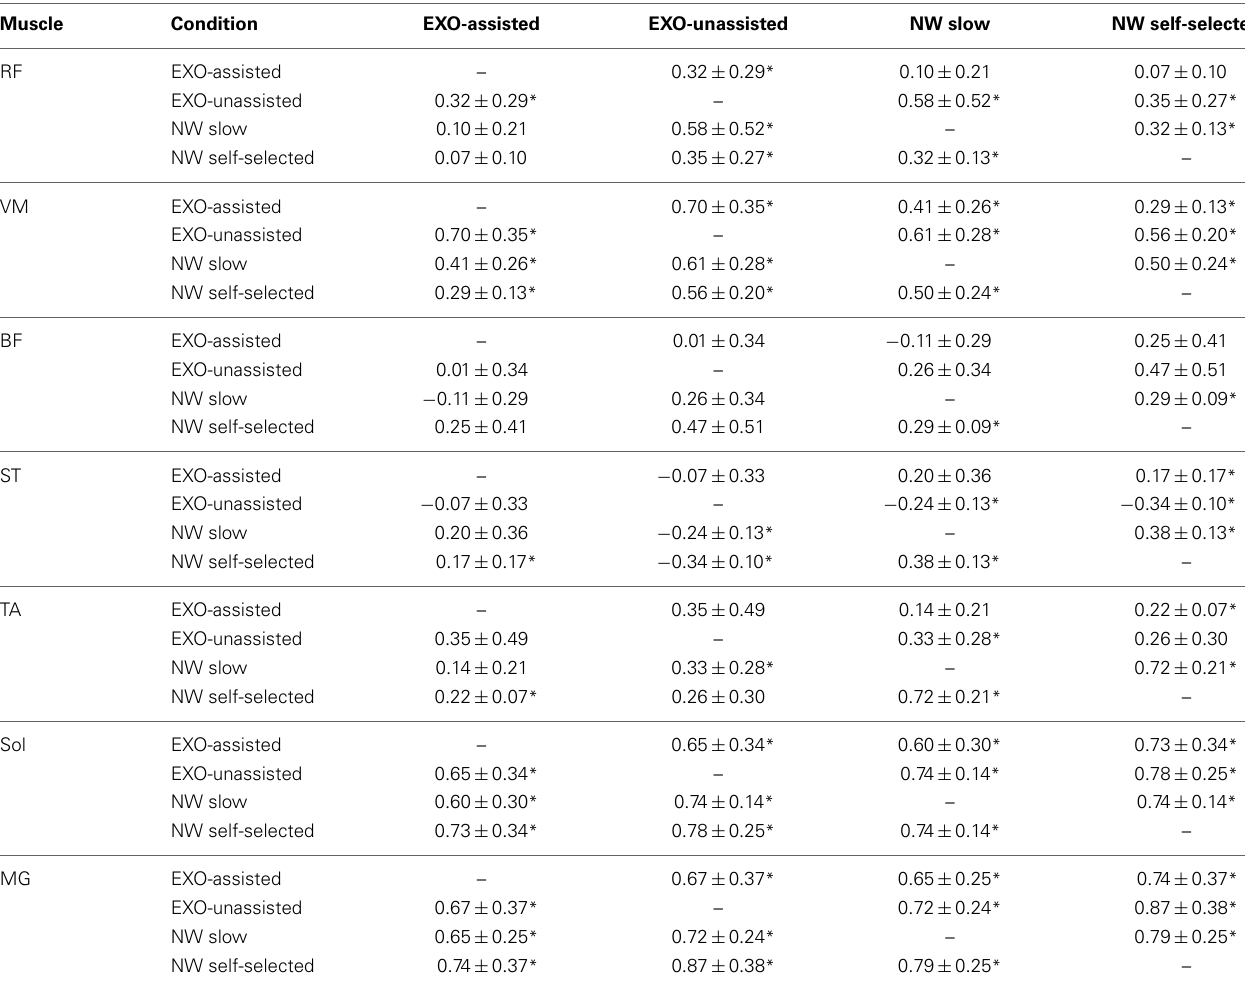
Table 2 | Pearson correlation coefficients (mean ± SD , n = 6) between EMG waveforms for different conditions in control subjects.